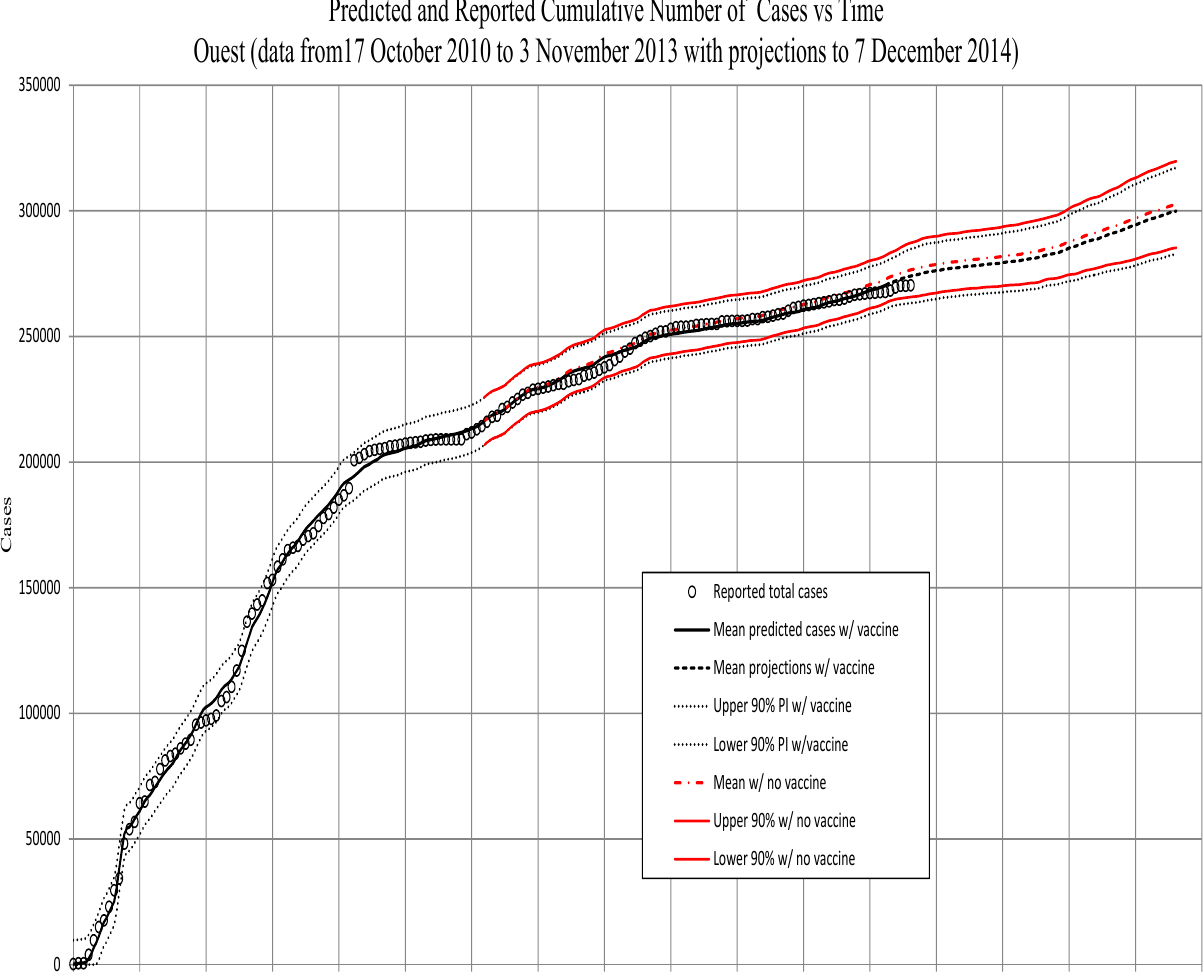
Figure 3. Ouest. The predicted cumulative number of symptomatic individuals, against total reported cases to 1 April 2012. Projections are from then to the end of February. Projections using the vaccination schedule (red) begin on 4 May 2012, approximately three weeks after beginning the vaccination program in Ouest. All projections after 11 November 2012, are based on runs using the prior 13 years of precipitation, and PI’s include the variance of those data (see the text). Note that for the Ouest region, the model begins at the fourth week. We assume that the low initial numbers in the first three weeks are a result of the immigration of cases from the Artibonite region. The model therefore uses data for the first four weeks (assumed immigration numbers for the first three weeks and the initialization of the model from data for the fourth